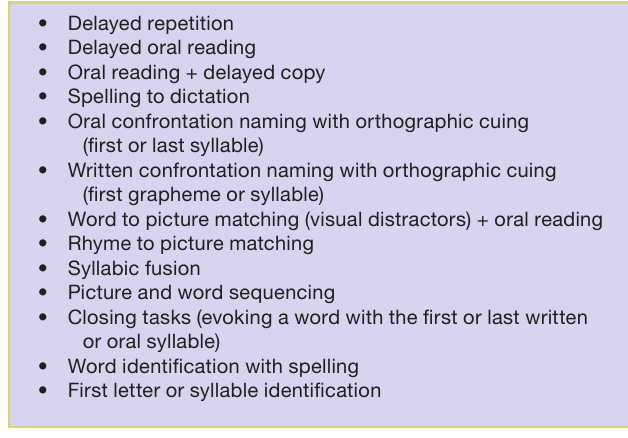
Table 1: Training tasks performed by